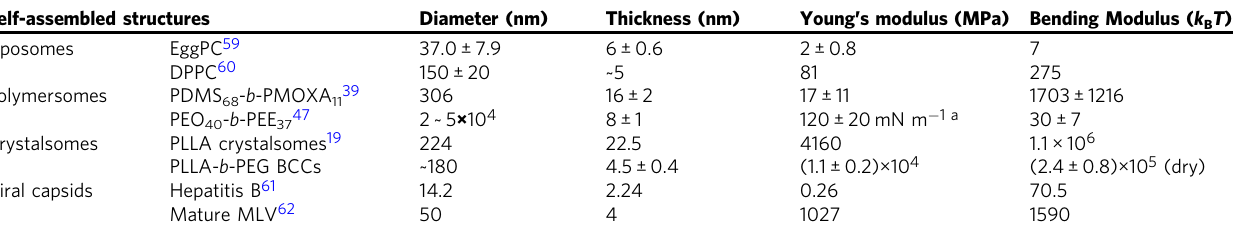
Table 1 A comparison of mechanical characteristics among liposomes, polymersomes, crystalsomes, and viral capsids. Self-assembled